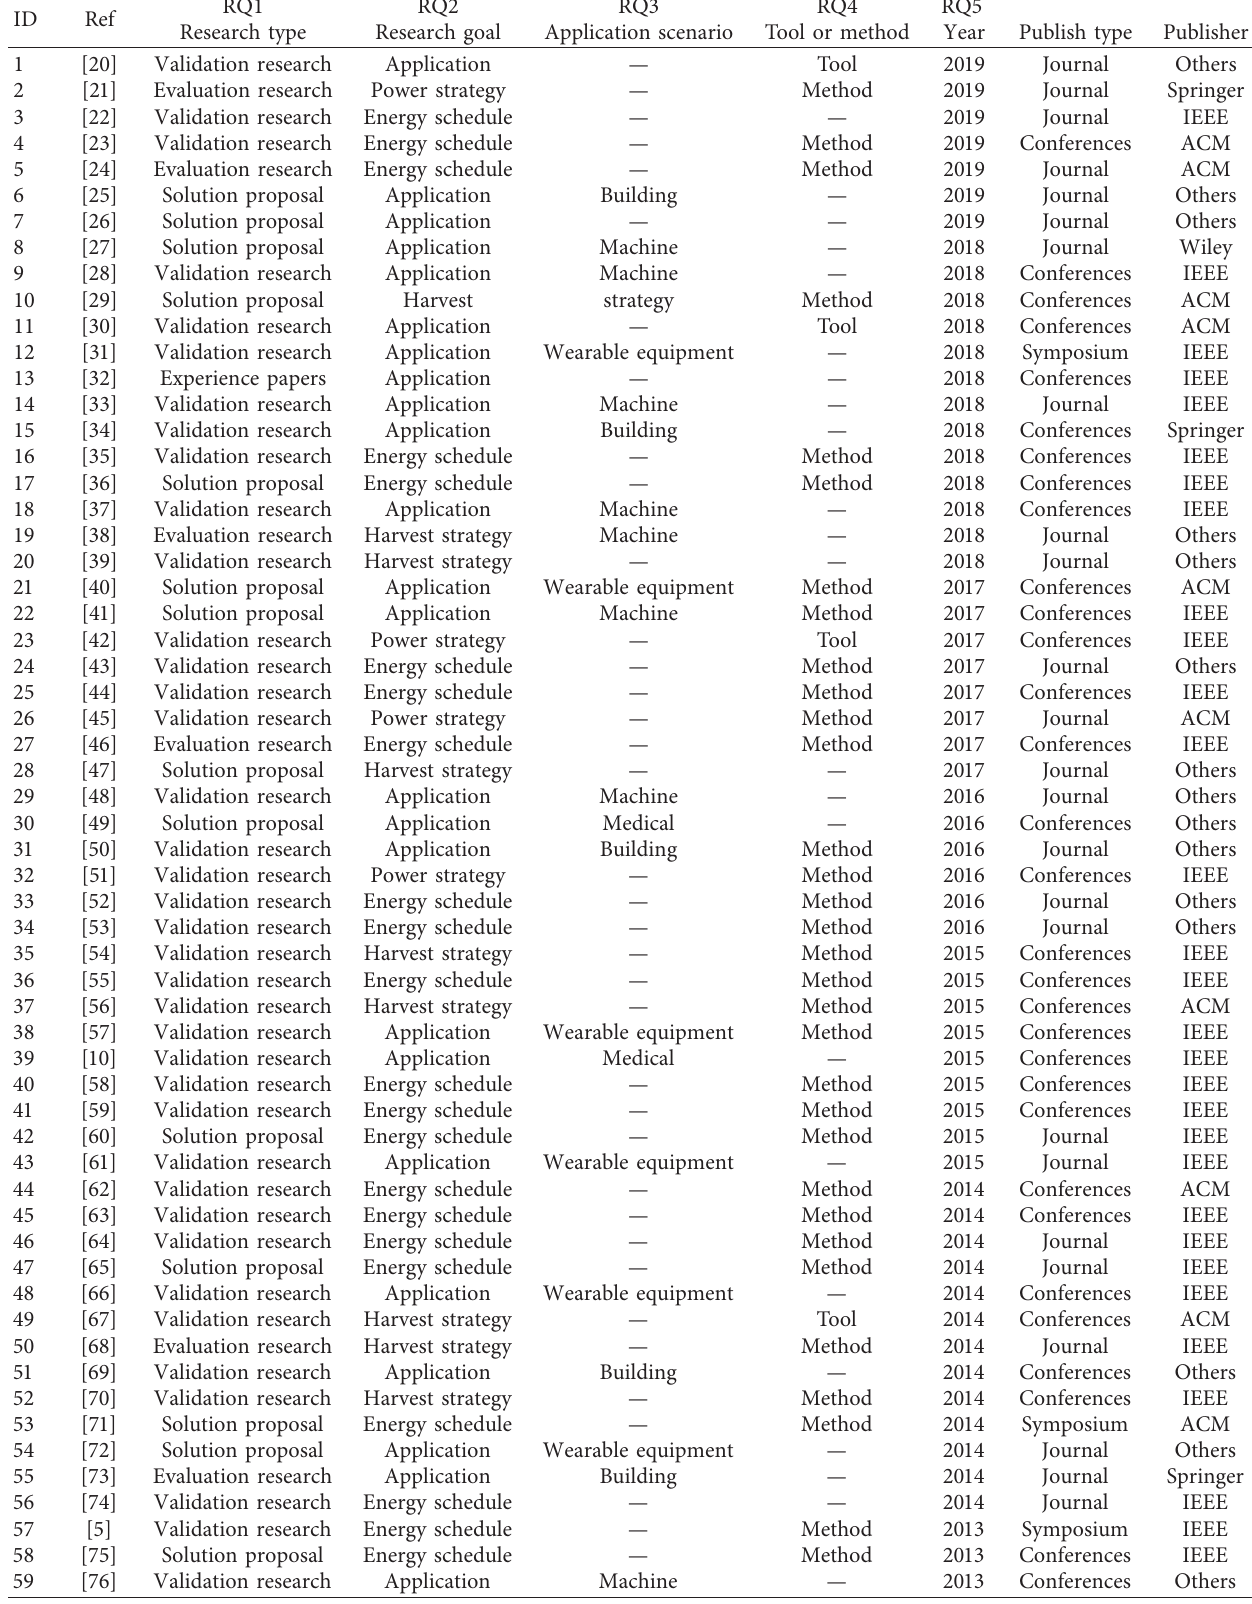
Table 4: Data extracted from the selected